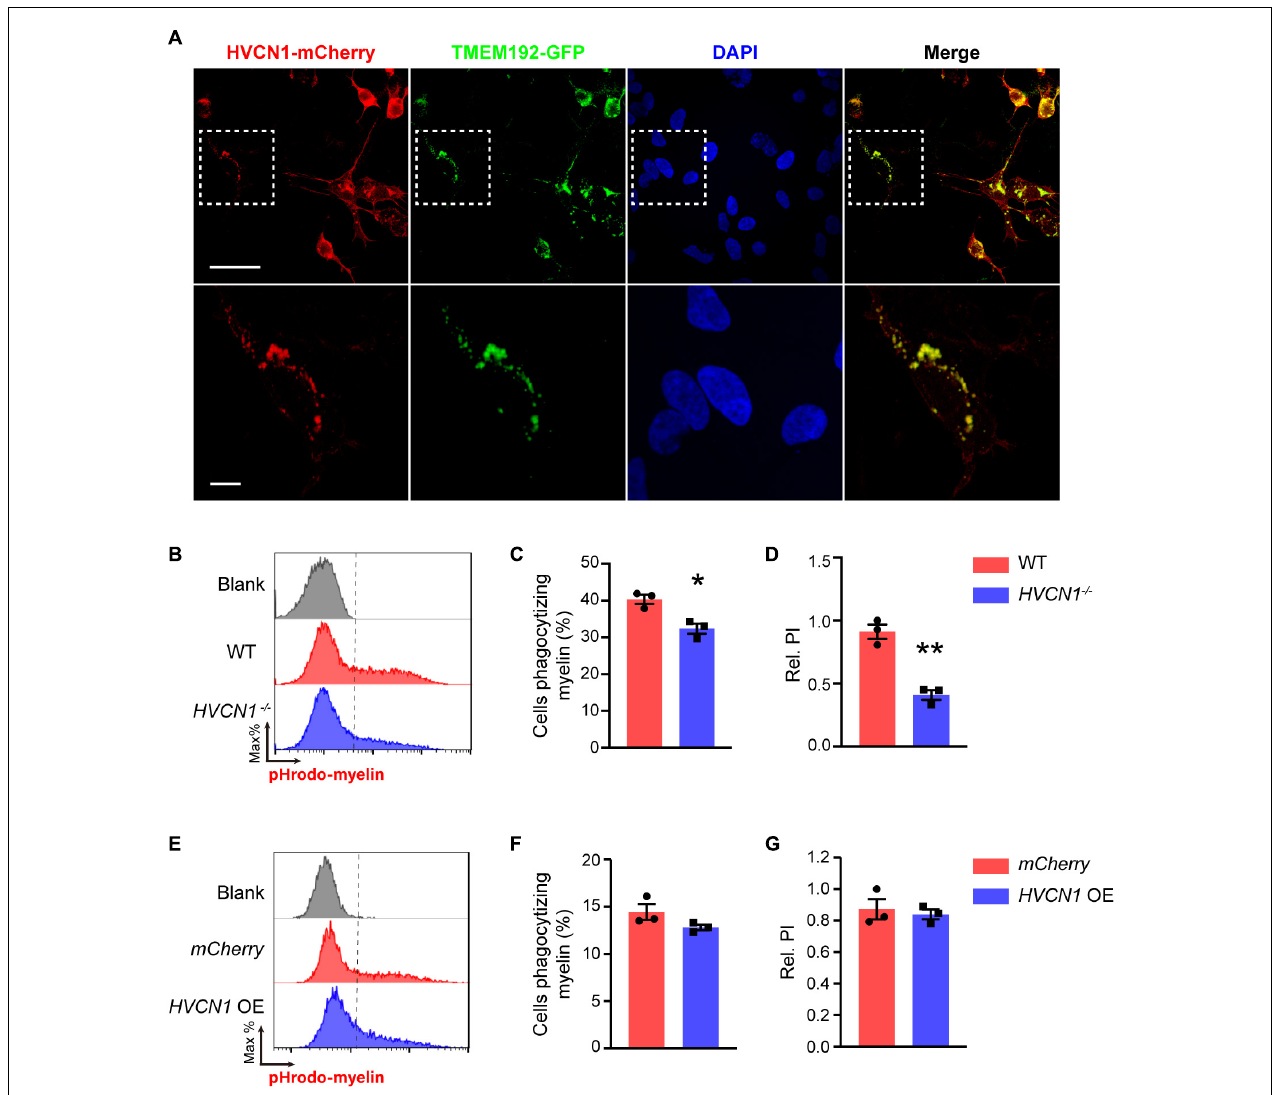
FIGURE 7 | HVCN1 deletion impairs lysosome acidification during myelin phagocytosis in vitro . (A) Representative images show that HVCN1 (red) is colocalized with lysosome marker TMEM192 (green) in 293T cells overexpressed Plenti-HVCN1-mCherry and TMEM192-GFP plasmid. Scale bar = 50 µ m (upper row) or 10 µ m (lower row). Flow cytometry chart (B) and the quantification graphs (C,D) show that HVCN1 knockout decreases both the proportion of cells phagocytizing myelin (C) and the relative phagocytic index (D) in pHrodo-myelin phagocytosis assay in 293T cells ( n = 3). Flow cytometry chart (E) and the quantification graphs (F,G) show that overexpression of HVCN1 does not affect the proportion of phagocytic cells (F) and the relative phagocytic index (G) in pHrodo-myelin phagocytosis assay in 293T cell ( n = 3). Data are presented as mean ± SEM. Statistical tests: unpaired two-tailed t -test (C,D,F,G) ; * p < 0.05, ** p <